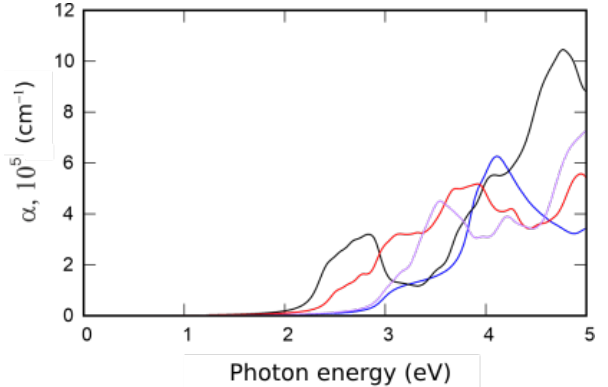
Figure 4. Absorption coefficient of XMAN 2 : SWSiN 2 (blue line), TeWSiN 2 (black line), SWGeN 2 (red line), and SeWSiN 2 (purple